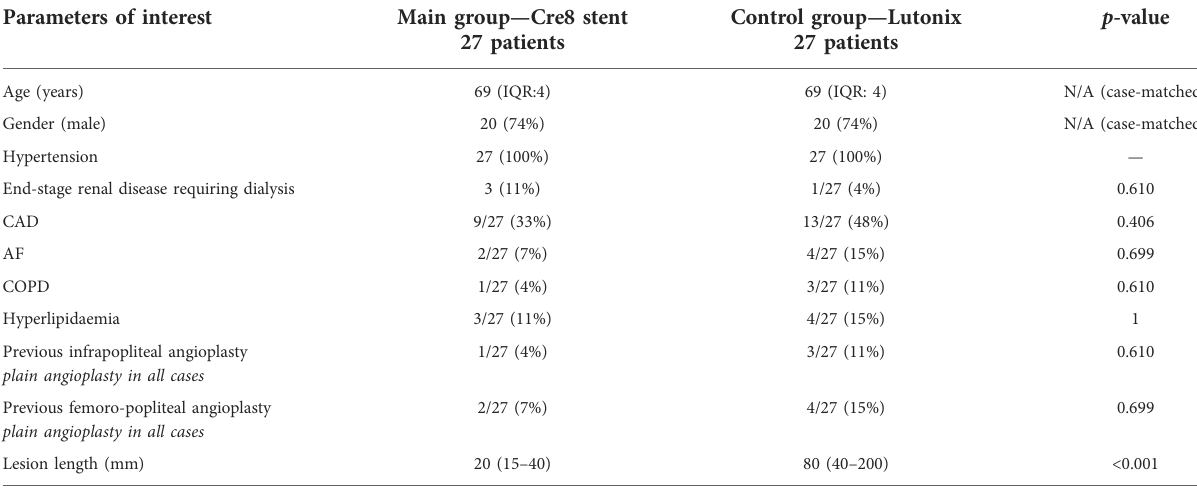
TABLE 1 Demographics and clinical characteristics of patients in the two study